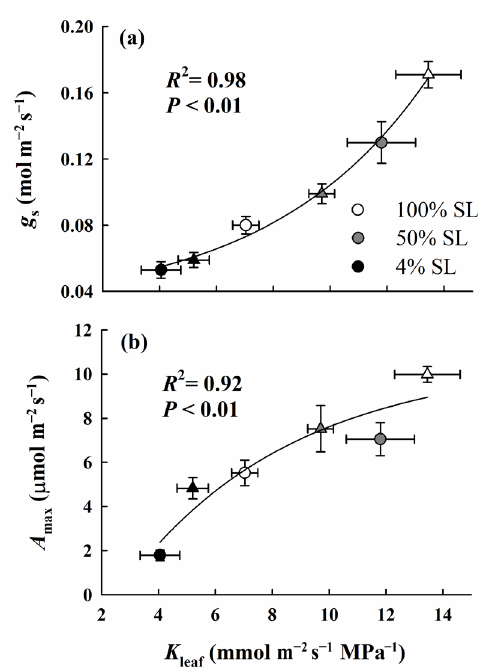
Figure 4. Correlations between leaf maximum hydraulic conductance and photosynthetic gas exchange traits, i.e., ( a ) stomatal conductance ( g s ) and ( b ) maximum photosynthetic assimilation rate ( A max ). Triangles and circles represent C. helferiana and C. rex , respectively. Values are means ± 1SE ( n = 4). Exponential equations were used to fit the curves: y = 0.03 + 0.01e 0.18x and y = -5.76 + 16.37 (1 – e − 0.17x ).